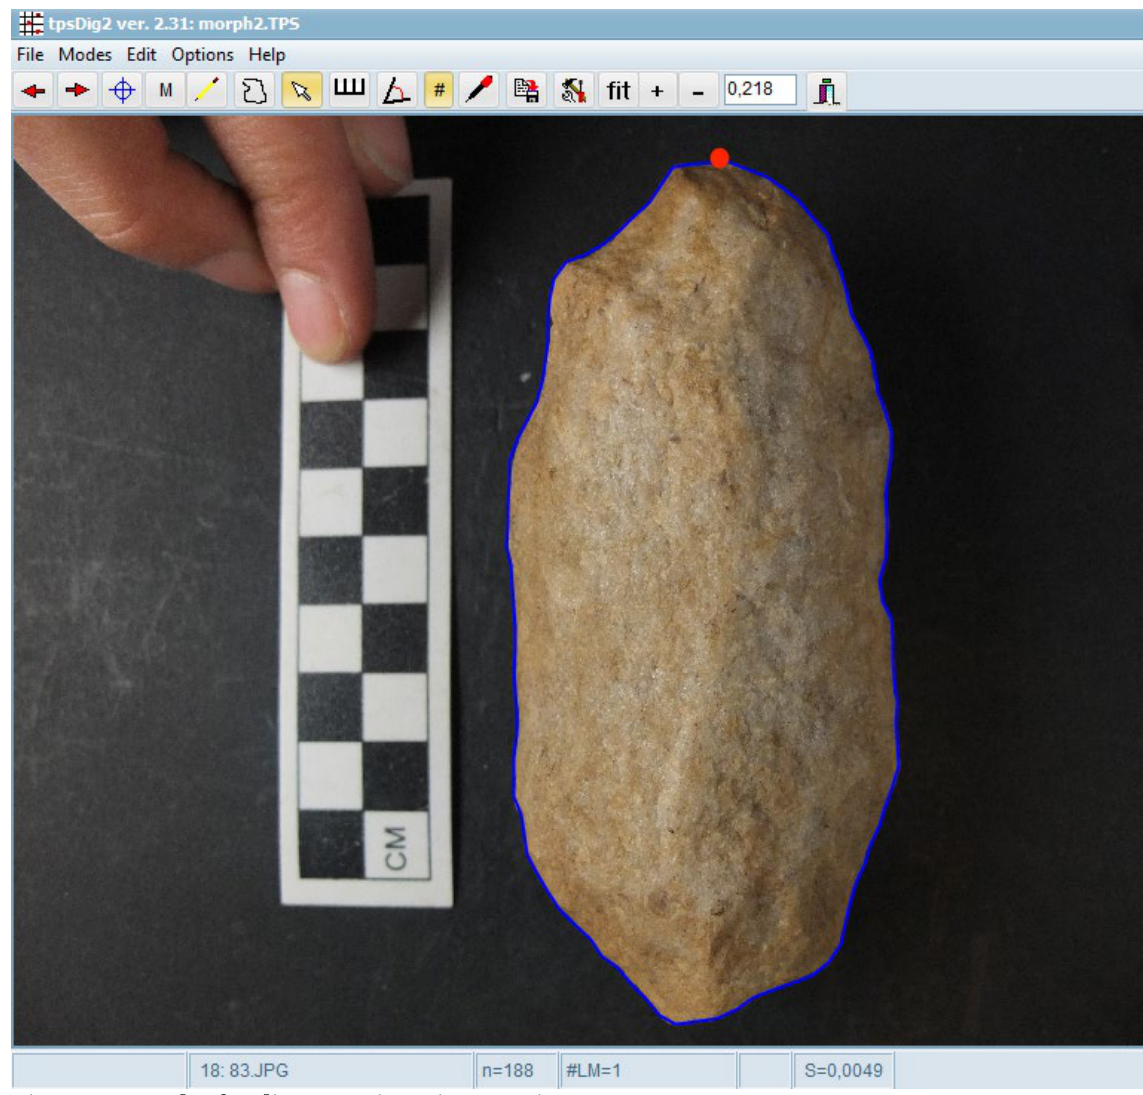
Figure 7. Example of outline extraction using